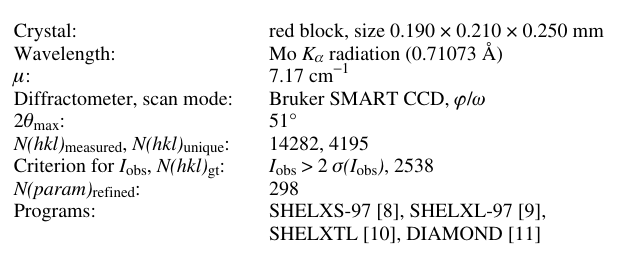
Table 1. Data collection and handling.